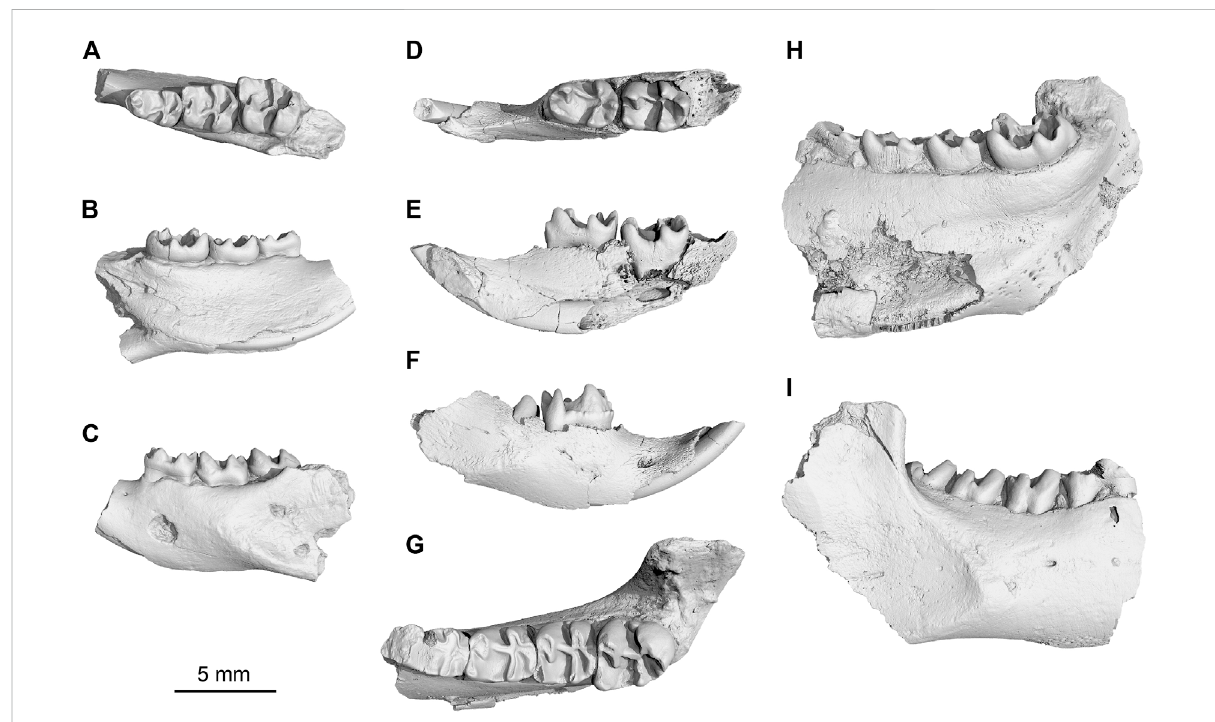
FIGURE 3 New Yuomys from the Gemusi pull-apart basin. (A – C) , Yuomys dawai sp. nov., IVPP V 31415, holotype, in occlusal, lingual, and buccal views; (D – F) , Yuomys gemuensis sp. nov., IVPP V 31417, in occlusal, lingual, and buccal views; (G – I) , Y. gemuensis sp. nov., IVPP V 31416, holotype, in occlusal, lingual, and buccal views.